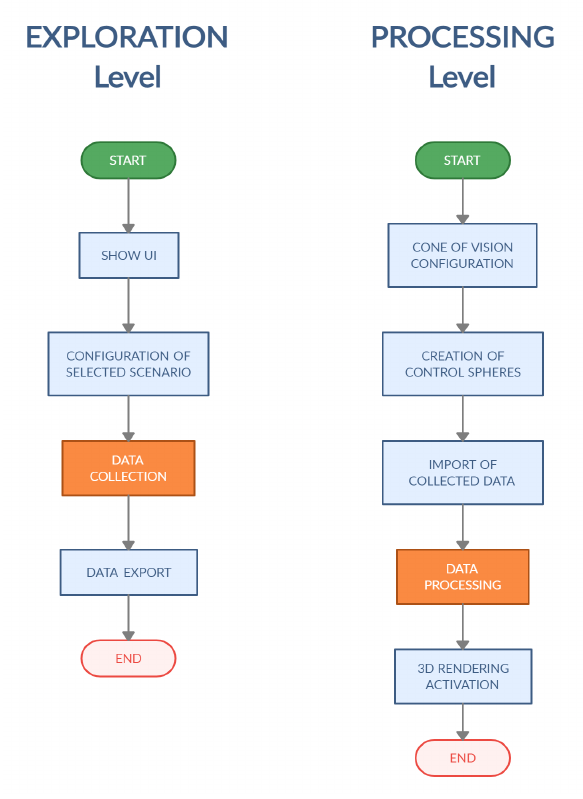
Figure 6. Flow chart of the two level